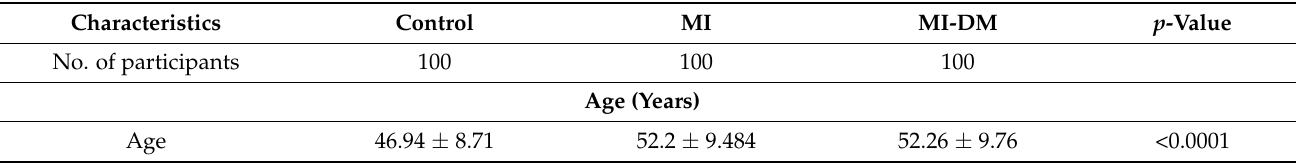
Table 2. Comparison of clinical parameters with anthropomorphic parameters among the control, myocardial infarction (MI), and myocardial infarction with diabetes mellitus (MI-DM) study groups.